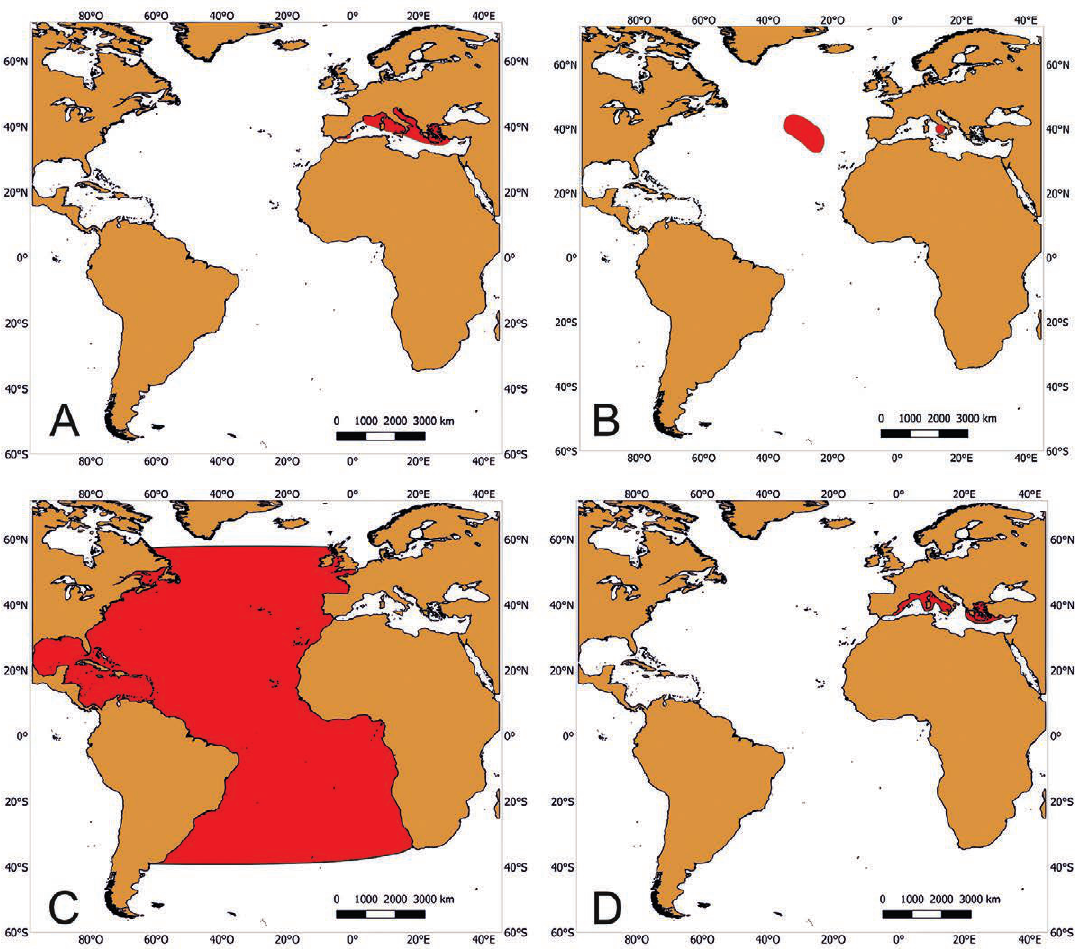
Fig. 2. – Maps of the geographic distribution (in black) of the species newly recorded in Tunisia: Leptopentacta tergestina (A), Ophiactis virens (B), Luidea atlantidea (C) and Asterina pancerii (D) (according to WoRMS, and López-Márquez et al. 2018, for Asterina pancerii